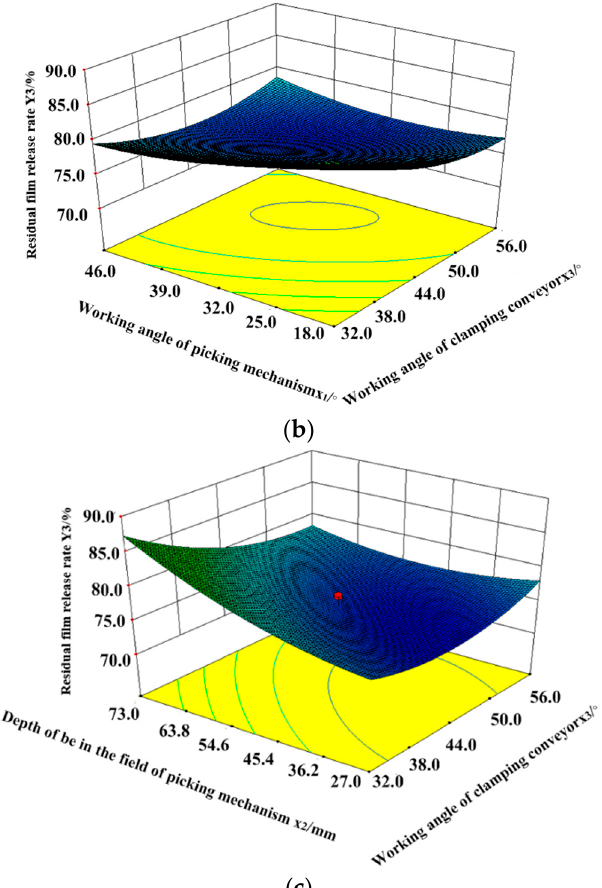
Figure 15. ( a ) The interactive response diagram of the release rate is influenced by the working angle and the depth into the soil of the film-picking mechanism. ( b ) The interactive response diagram of the release rate is influenced by the working angles of the film-picking mechanism and the clamping conveyor mechanism. ( c ) The interactive response diagram of the release rate is influenced by the depth into the soil of the film-picking mechanism and the working angle of the clamping conveyor mechanism.